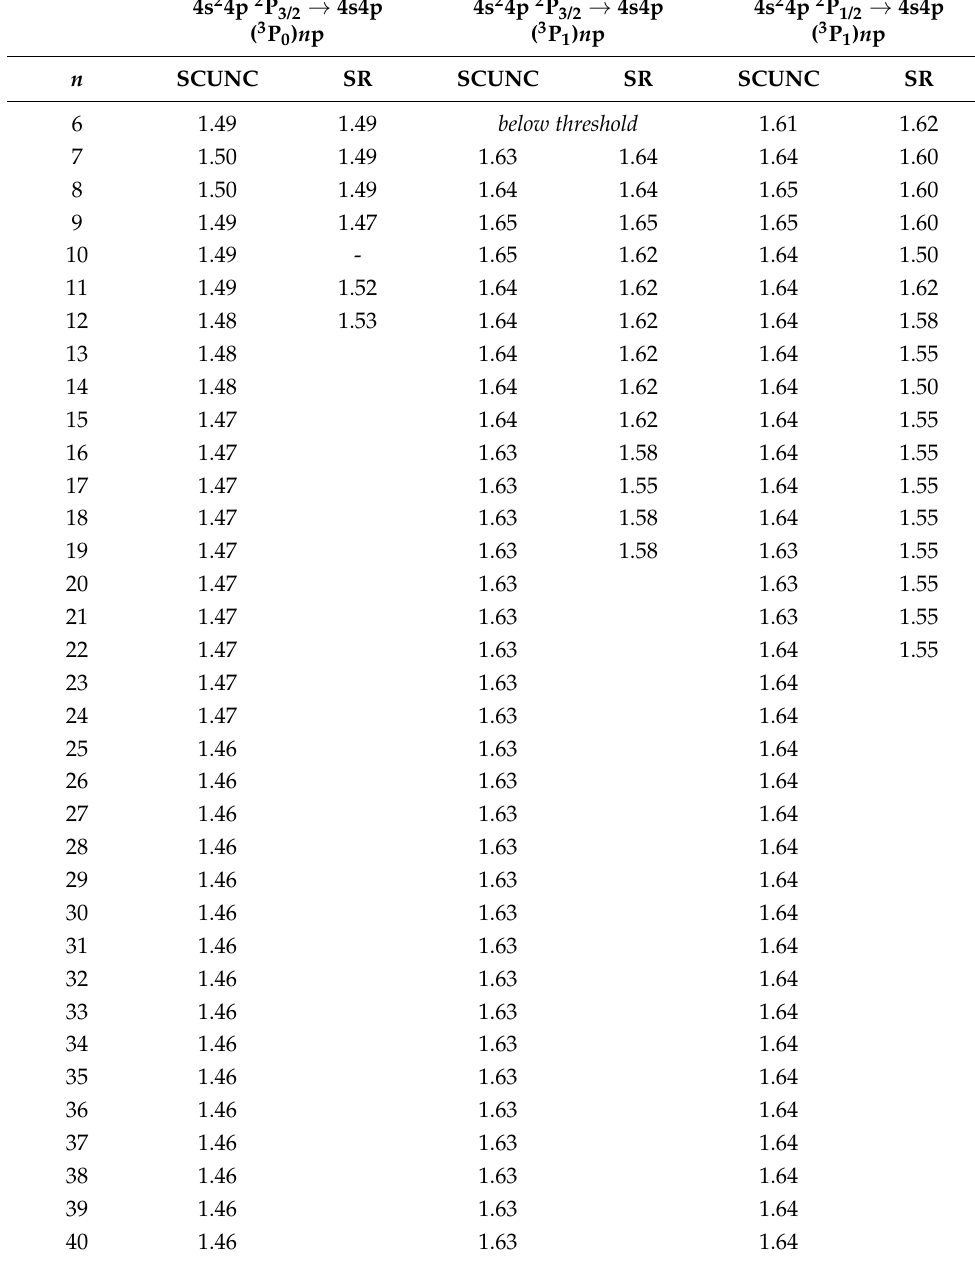
Table 2. Quantum defects (dimensionless) of the 4s4p ( 3 P 0,1 ) n p Rydberg series originating from the 4s 2 4p 2 P 1/2,3/2 states of Se 3+ converging to the 3 P 0,1 series limits in Se 4+ . The SCUNC results are compared to the SR data of Esteves et al.